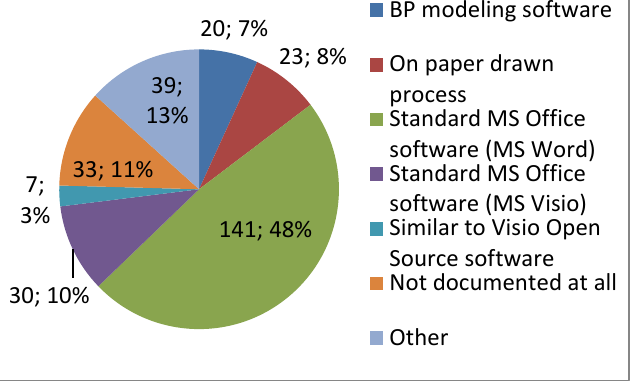
Fig. 6. The use of software for process documentation.